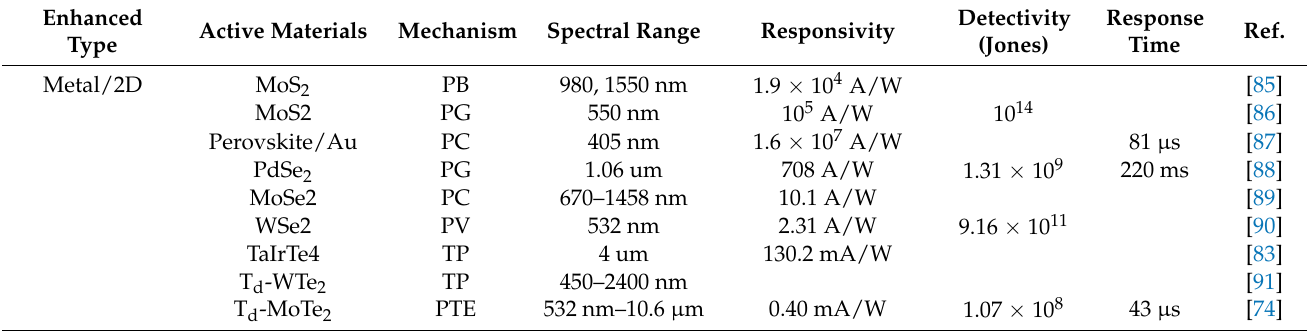
Table 1. Performance of 2D and bulk material